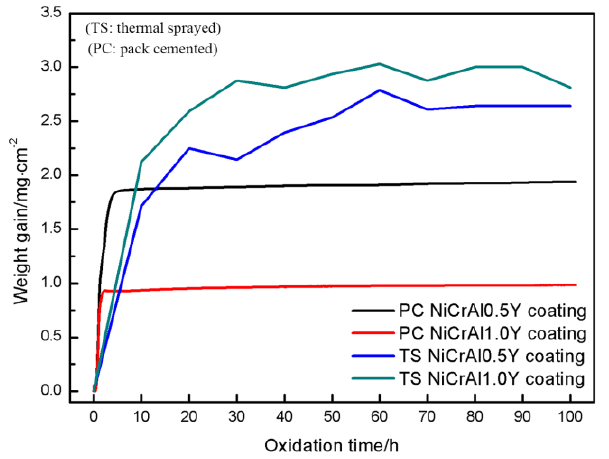
Figure 13. Oxidation resistance comparison of TS and PC NiCrAlY coatings with equal amount of Y.